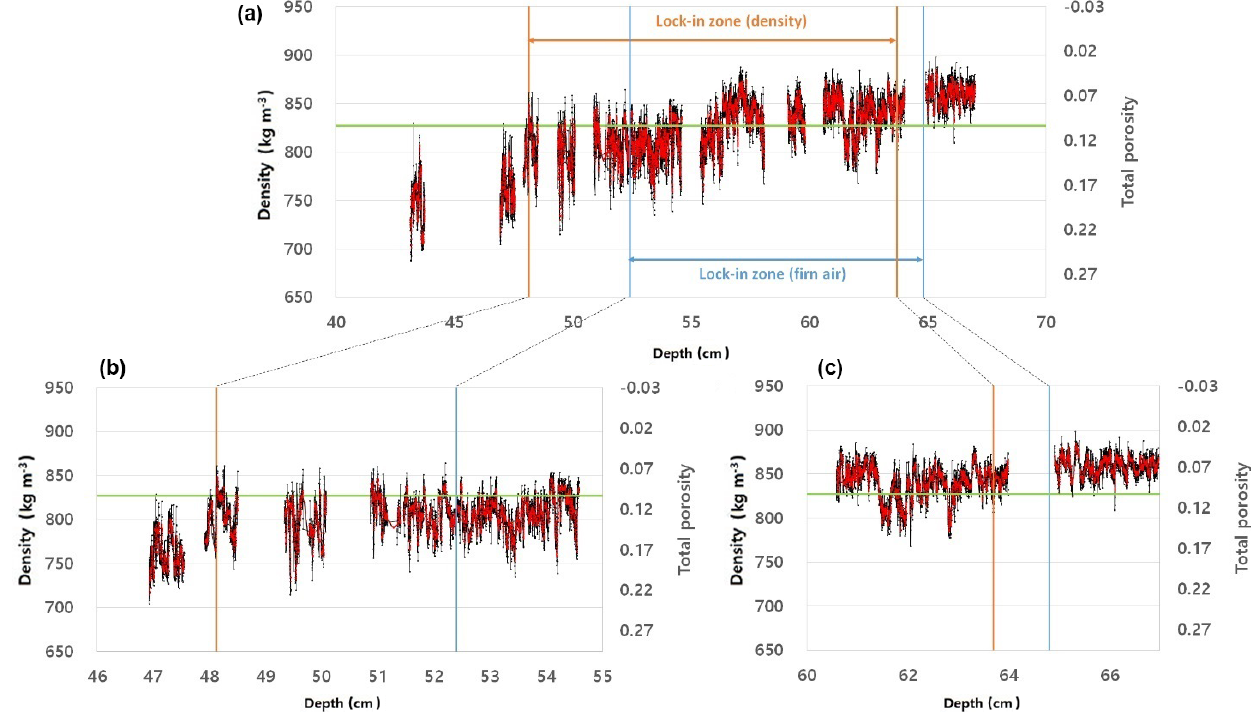
Figure 6. High-resolution X-ray density data obtained from the lock-in zone. Panels (b) and (c) are enlarged portions of panel (a) . Black lines show individual density data, while the red lines are 1cm running means. Blue and orange lines represent the boundaries of the LIZ estimated from the gas compositions (between two vertical blue lines) and the critical porosity thresholds (between two orange vertical lines), respectively (see Sect. 3.4).